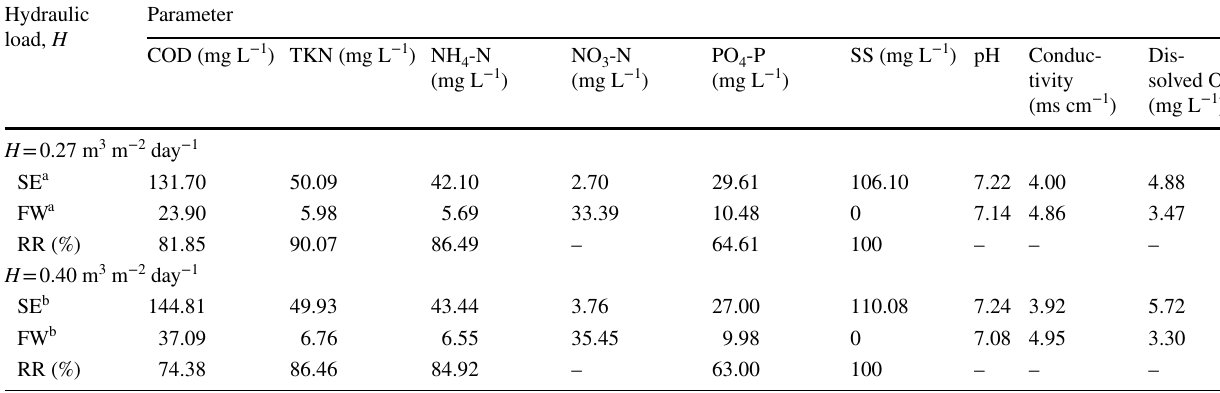
Table 2 Physicochemical characteristics of secondary effluents and filtered water (mean values)